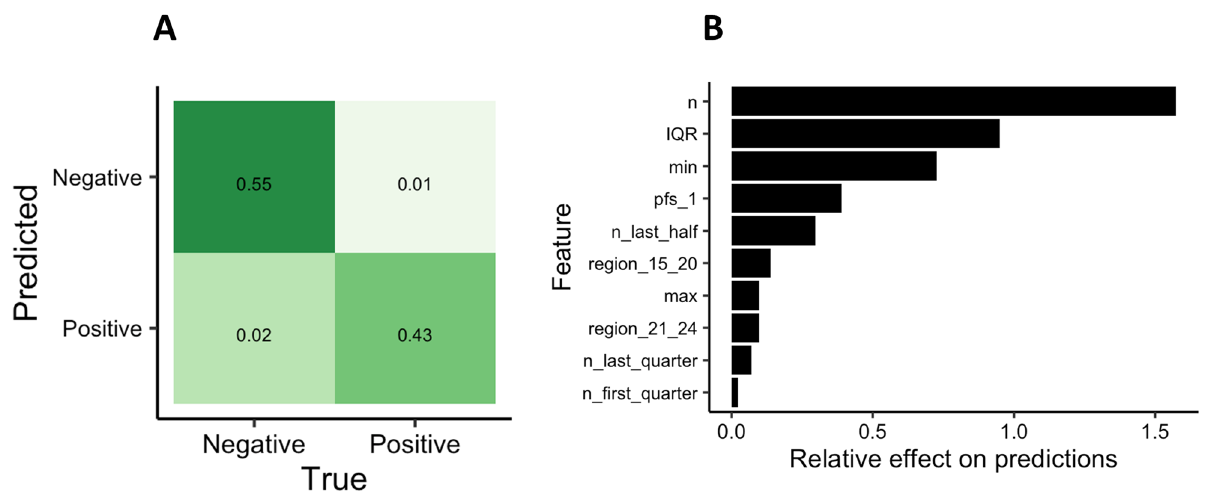
Figure 5. Model performance and the most important features. RuleFit classifier model performance for Watson–Crick base pairing. ( A ) Confusion matrix showing percentages of actual assay outcomes versus outcomes produced by the classifier model, ( B ) relative effect of features on model predictions: n—number of mismatches, IQR—interquartile range for mismatch positions (characterizes distribution of mismatches with IRQ = 14 indicating even distribution and IRQ > 14 and IRQ < 14 indicating clustering), min—position of mismatch closest to 5’ end of crRNA, PFS_1—nucleotide at protospacer flanking site #1, range—distance between the furthest apart mismatches, remaining features corresponding to various regions of crRNA as described in Fig.